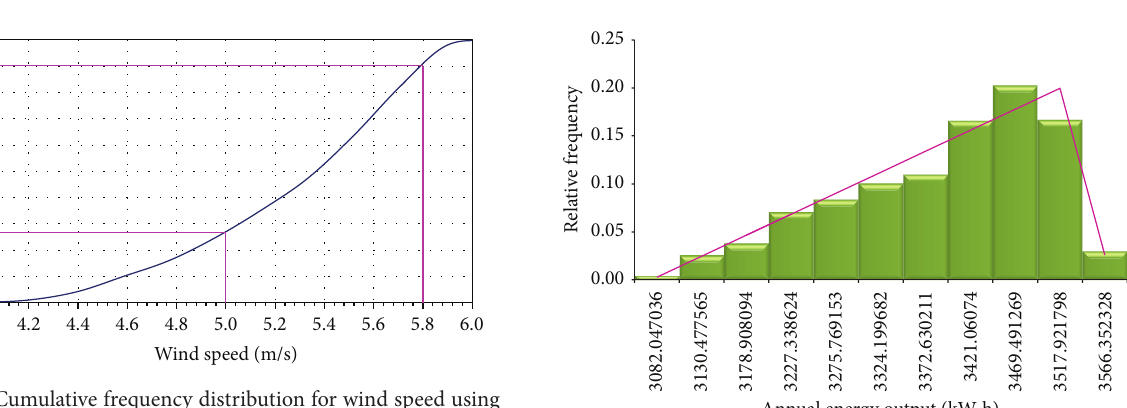
Figure 2: Cumulative frequency distribution for wind speed using Monte Carlo simulation.